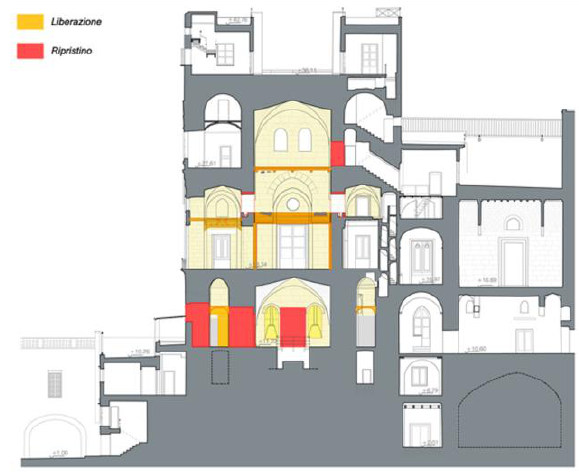
Figure 4. Interior of Palatine Chapel. Raster image with the surveyed profile (Monti, 1993)